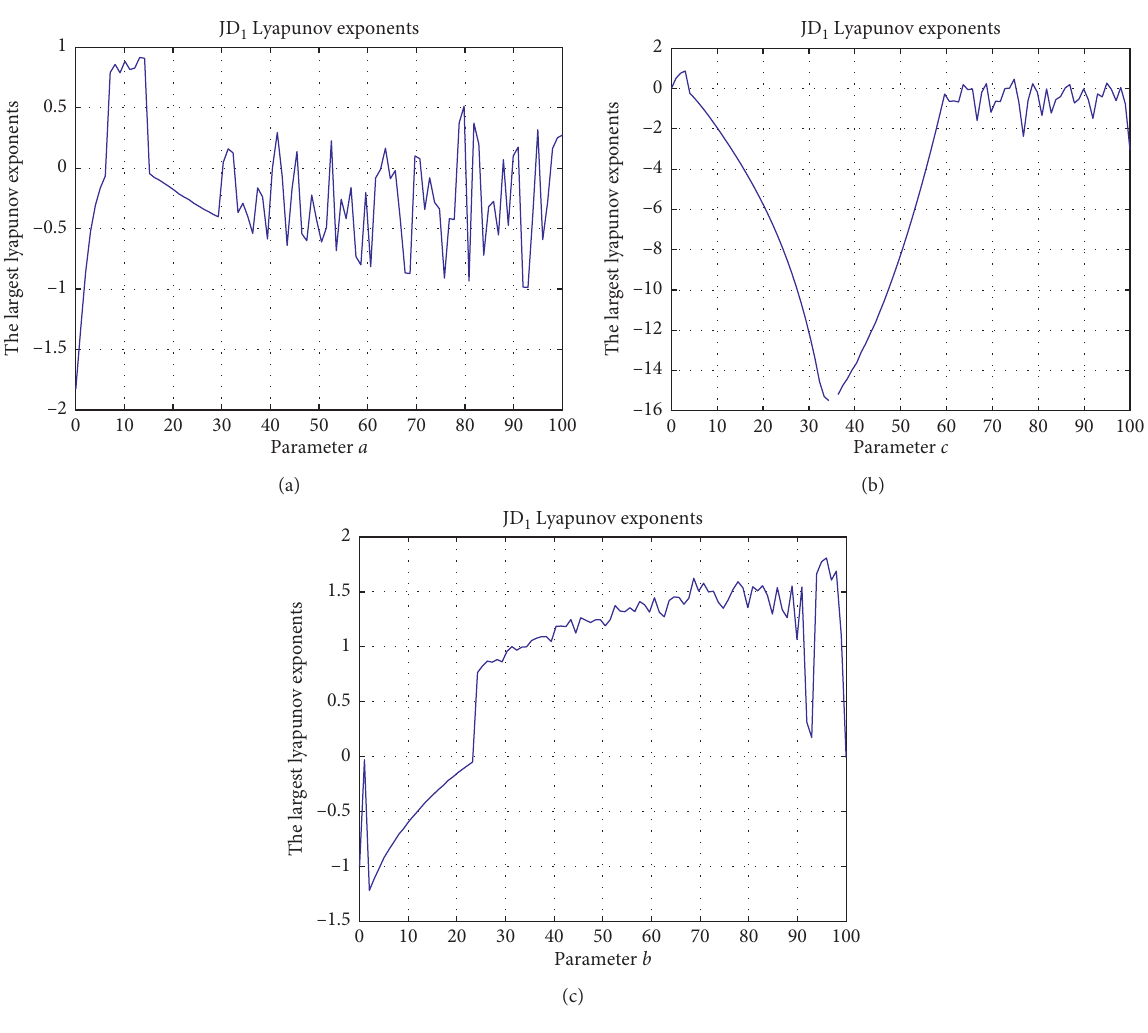
Figure 1: The LE values of the Lorenz